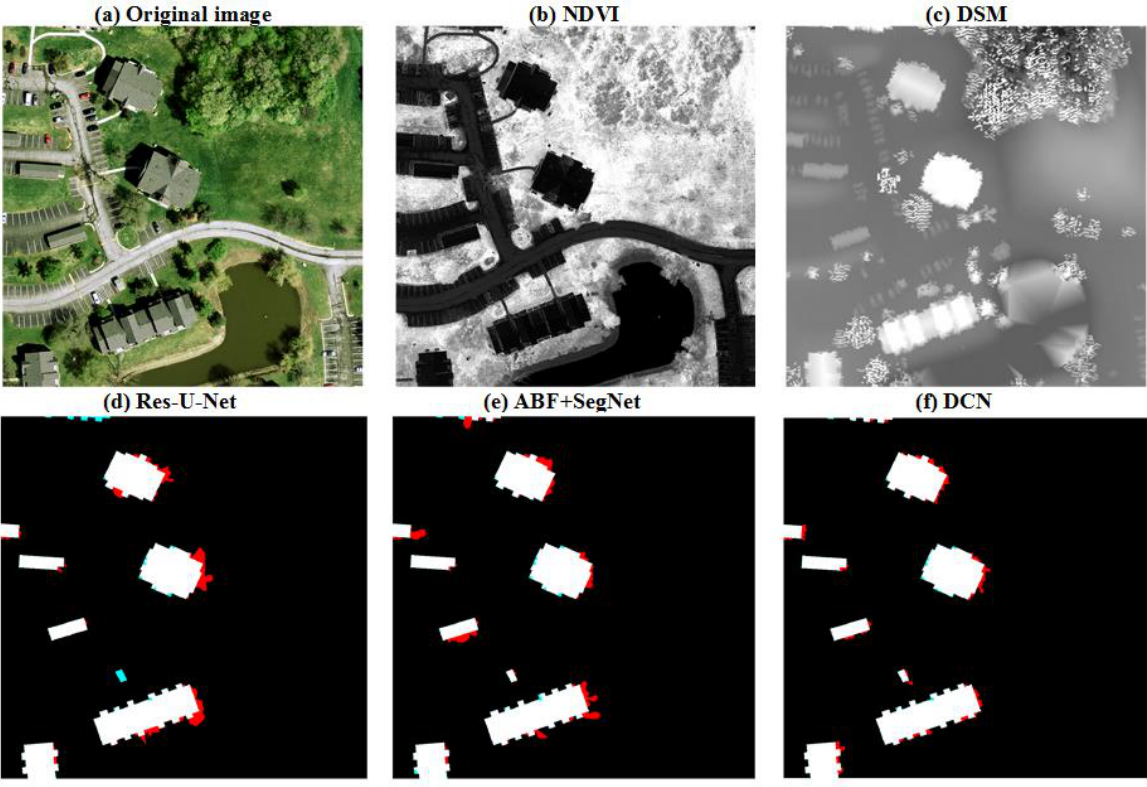
Figure 3. Comparison of BFE results using Res-U-Net, ABF+SegNet and DCN with ground truth in Case-1